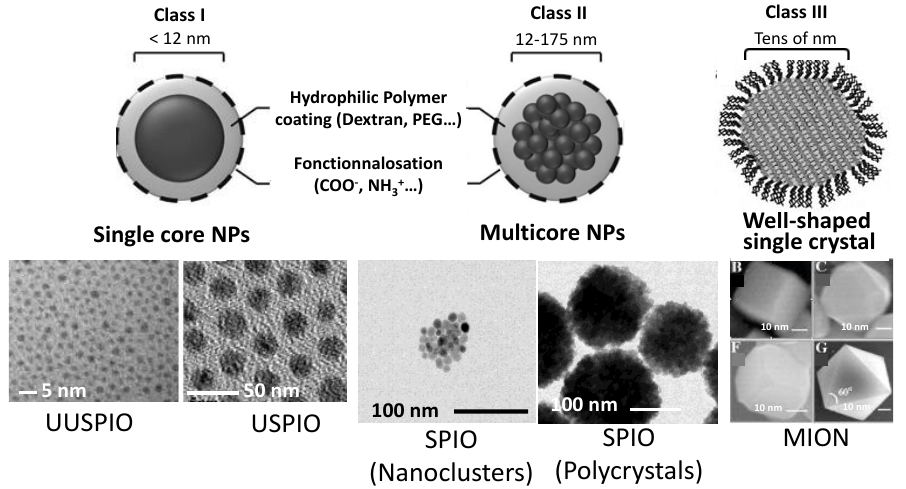
Figure 4. Schematic representation of the three main iron oxide-based contrast agents and selected TEM images.